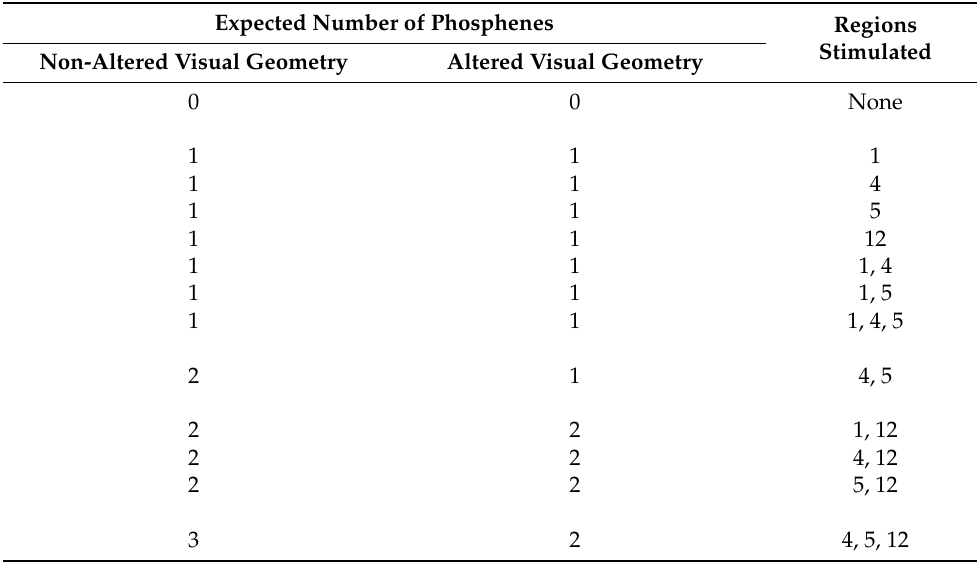
Table 2. The 13 conditions that provide examples and classifications of numbers of phosphenes for the non-altered and altered visual